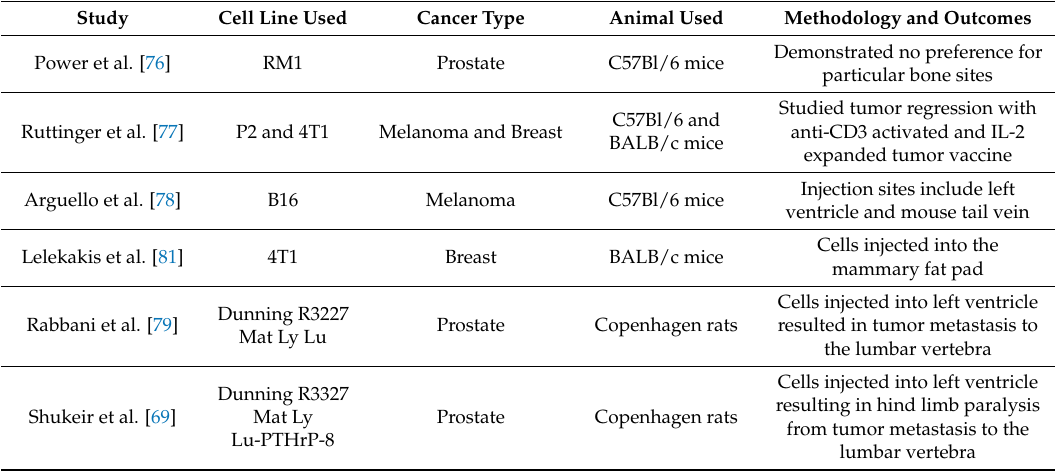
Table 3. Immunocompetent